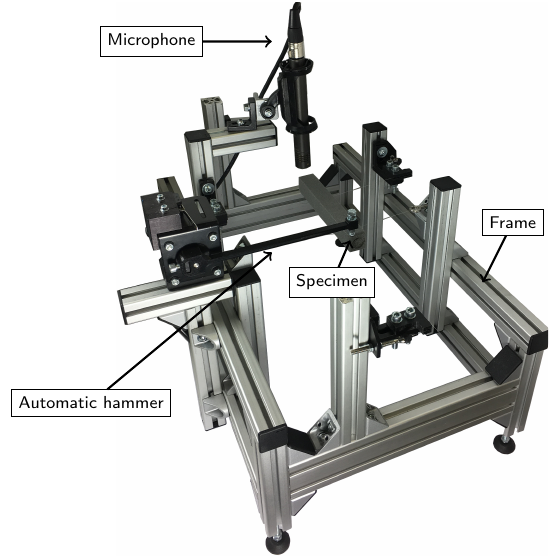
Figure 1. Test-bench for determining elastic properties via impulse excitation technique. The main components are a microphone, a specimen, an automatic hammer system and the frame of the